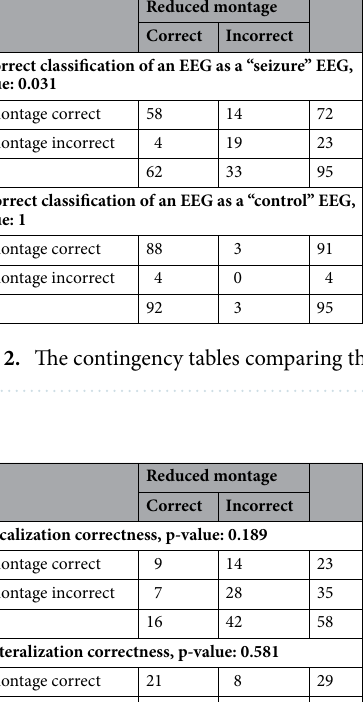
Reduced montage Correct Incorrect